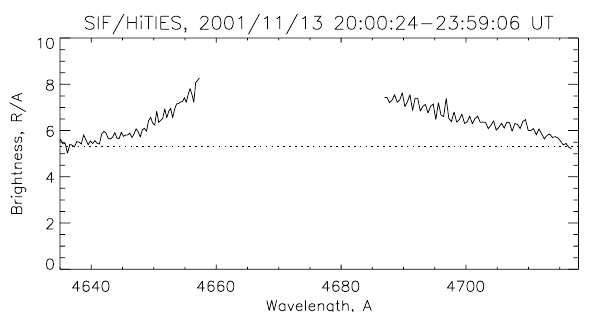
Fig. 6. Night-sky spectrum devoid of aurora on 13 November 2001, showing the background emissions in the N + N + 1N(1,3) 2